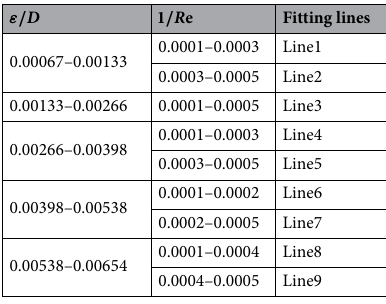
Table 3. Model tree parameters.